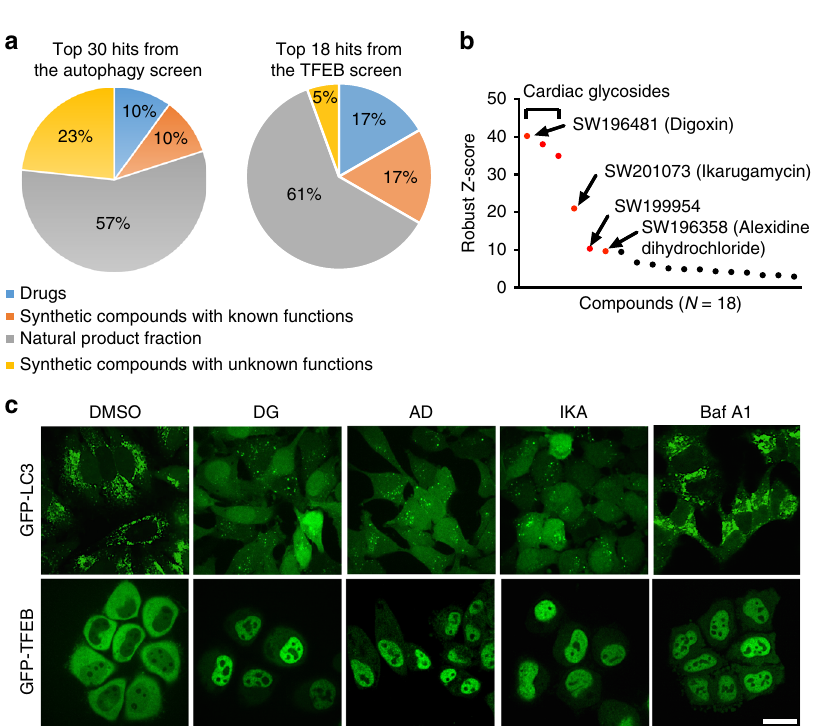
Fig. 2 High-throughput screen for small-molecule agonists of TFEB. a Pie charts showing the composition of the top 30 hits from the autophagy screen (left) and the top 18 hits from the TFEB screen (right). The top 18 hits include 3 FDA-approved drugs (digoxin, proscillaridin A, and digoxingenin), 11 natural product fractions and 4 synthetic small molecules (including alexidine dihydrochloride and cycloheximide). b Robust Z -score plot of the top 18 chemicals in the TFEB screen that overlap with the top 30 hits from the autophagy screen. c Representative images of GFP-LC3 and GFP-TFEB HeLa cells treated with 370 nM DG, 3.3 μ M AD, and IKA and 50 nM ba fi lomycin A1 (Baf A1). GFP-LC3 HeLa cells were pretreated with UPS 4.4 prior to a 4 h compound exposure. Baf A1, which blocks autolysosomal degradation through inhibition of vacuolar ATPases, was used as a negative control. In GFP-TFEB HeLa cells, the same concentration of compounds was used without UPS 4.4 , while Baf A1 was used as a positive control. Scale bars, 20 μ